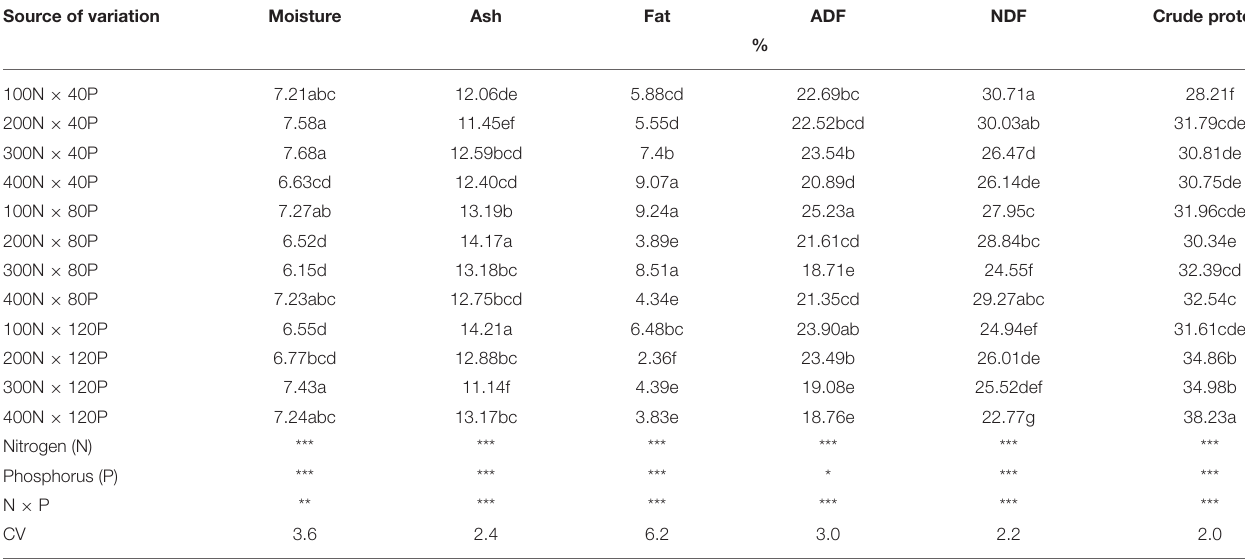
TABLE 3 | Effect of nitrogen and phosphorus treatment combinations on moisture and chemical compositions of moringa leaves. Source of variation